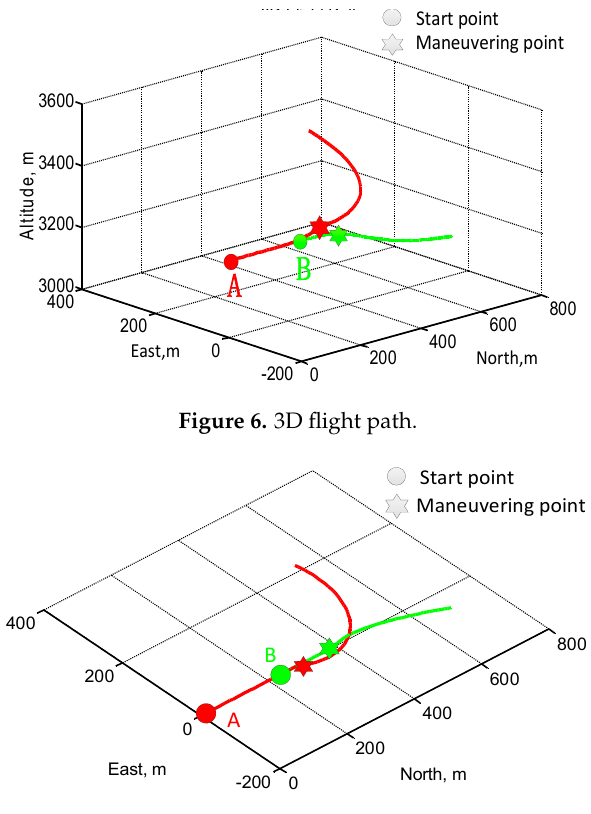
Figure 7. 2D flight path.